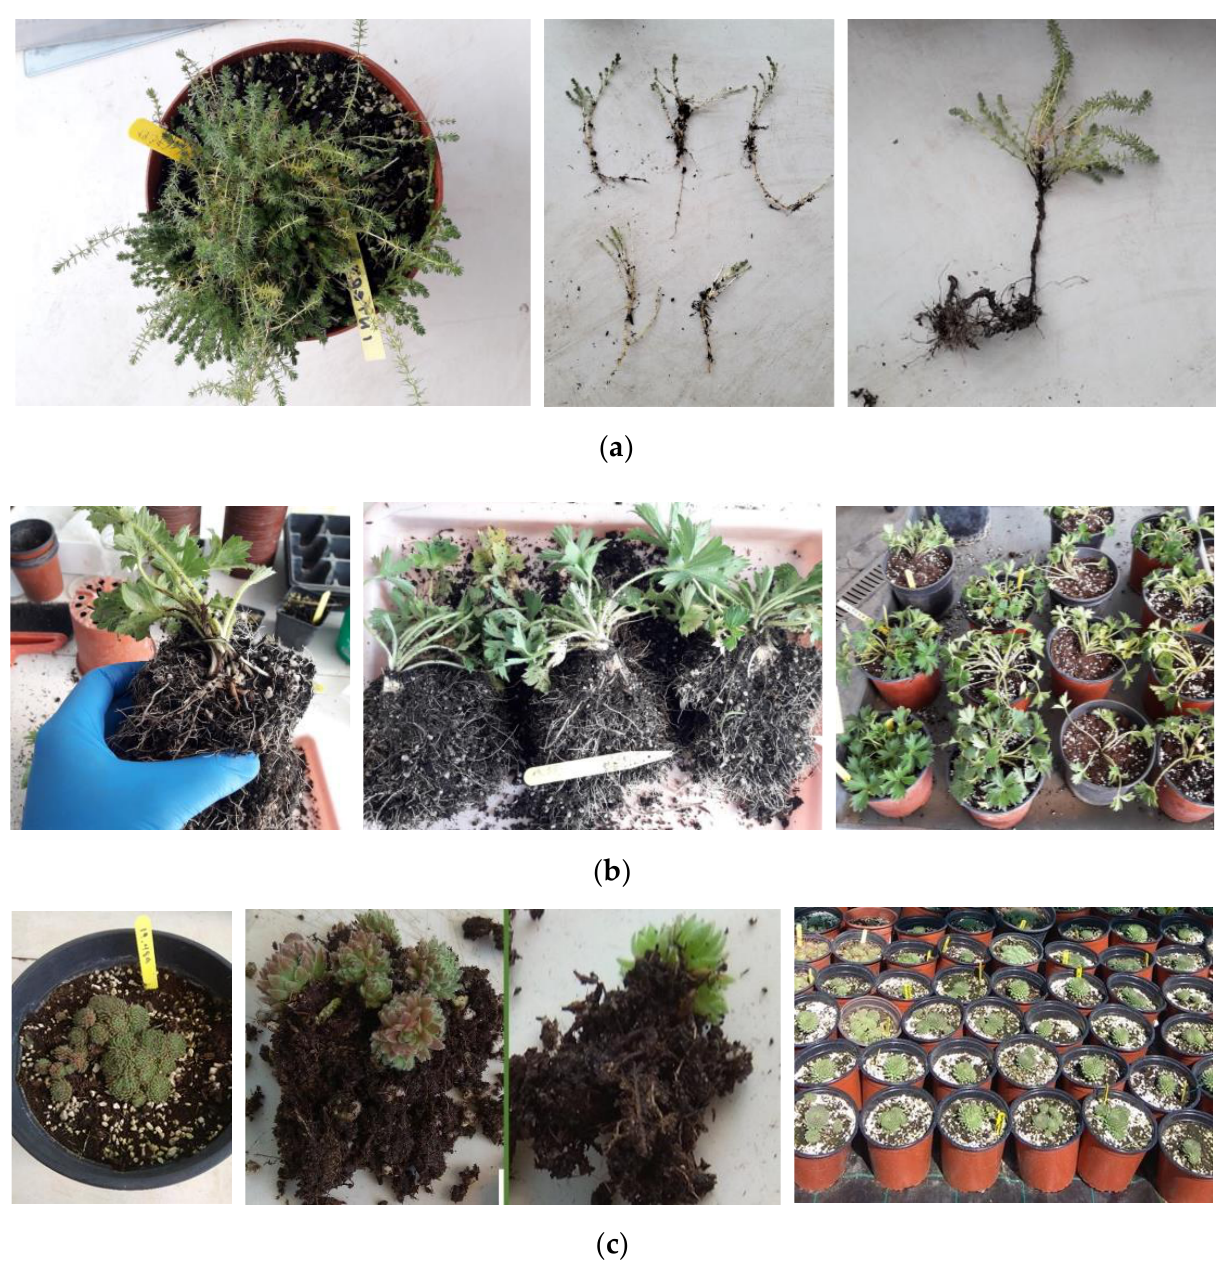
Figure 6. Representative photos of asexual propagation via plant division (mother plant, divided daughter plants) of wild-growing plants in different conservation priority categories. ( a ) Priority A1 taxon Galium rhodopeum (Rubiaceae) with accession number 19,373; ( b ) Priority B4 taxon Ranunculus sartorianus (Ranuculaceae) with accession number 1955; ( c ) Priority C2 taxon Sempervivum ruthenicum (Crassulaceae) with accession number 19,489.